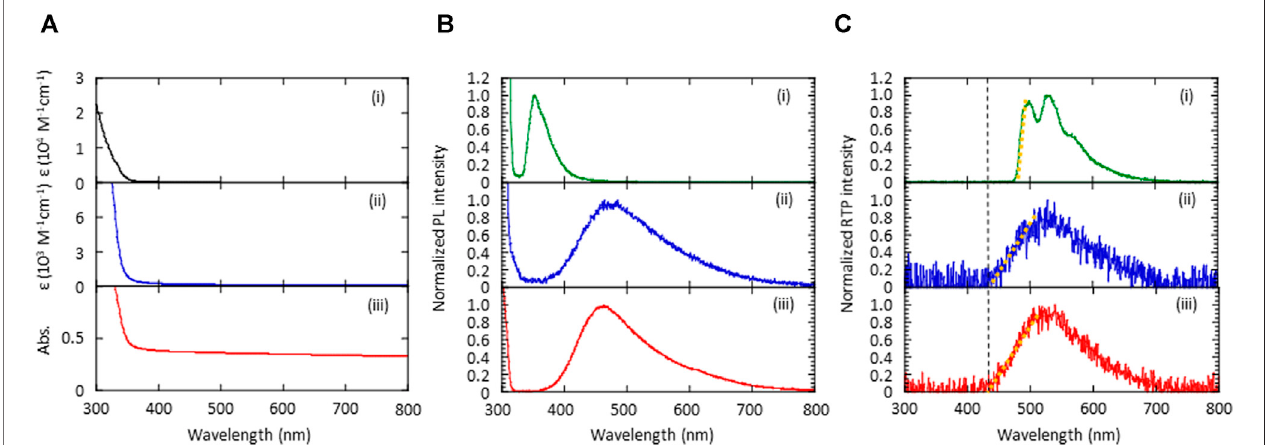
FIGURE 3 | Absorption and emission spectra of ( S )-BINAP molecularly dispersed in 2Me-THF (i), an amorphous ( S )-H 8 -BINAP fi lm (ii), and a crystalline ( S )-H 8 - BINAP fi lm(iii). (A) Absorptionspectra. (B) Fluorescencespectraobtainedbyexcitationat300 nmatRT. (C) Phosphorescencespectraobtainedafterceasingexcitation at 300 nm at 77 K. The orange dotted lines in the graph were used to determine the onset energy of T 1 . (2Me-THF (cid:1) 2-methyltetrahydrofuran; RT (cid:1) room-temperature; ( S )-BINAP (cid:1) ( S )-( − )-2,2 ′ -bis(diphenylphosphino)-1,1 ′ -binaphthyl ( S )-H 8 -BINAP (cid:1) ( S )-bis(diphenylphosphino)-5,5 ′ ,6,6 ′ ,7,7 ′ ,8,8 ′ -octahydro-1,1 ′